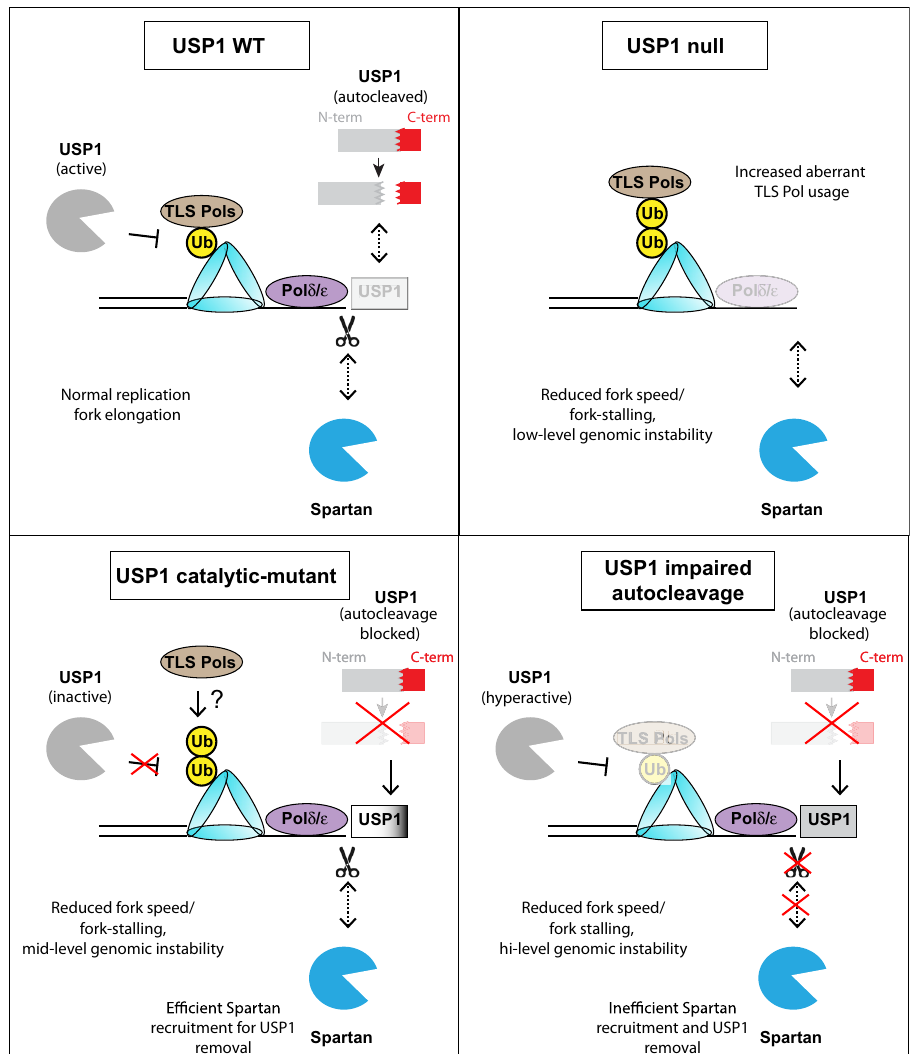
Fig. 6 Model for the role of USP1 activity and/or autocleavage during normal DNA replication progression. During unperturbed replication, low levels of PCNA ubiquitylation allow for ef fi cient TLS to overcome various replicative lesions, and autocleavage allows USP1 to be dynamically recruited to the fork. By contrast, the complete absence of USP1 activity leads to increased aberrant TLS Pol usage due to hyperubiquitylation of PCNA, resulting in reduced replication fork speed and low-level genomic instability. Impaired USP1 autocleavage caused by mutations disrupting the catalytic activity (C90S) or autocleavage site (GG/AA) additionally causes increased fork stalling and replication stress due to increased retention (i.e., “ trapping ” ) of USP1 on